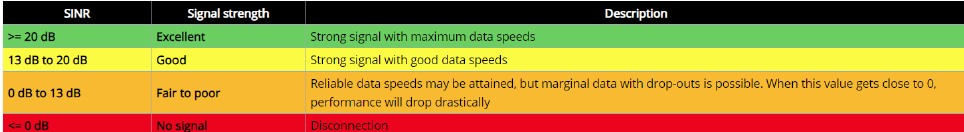
Figure 3. Descriptions of signal strengths for different signal to interference and noise ratio (SINR) values for Long-term evolution technology